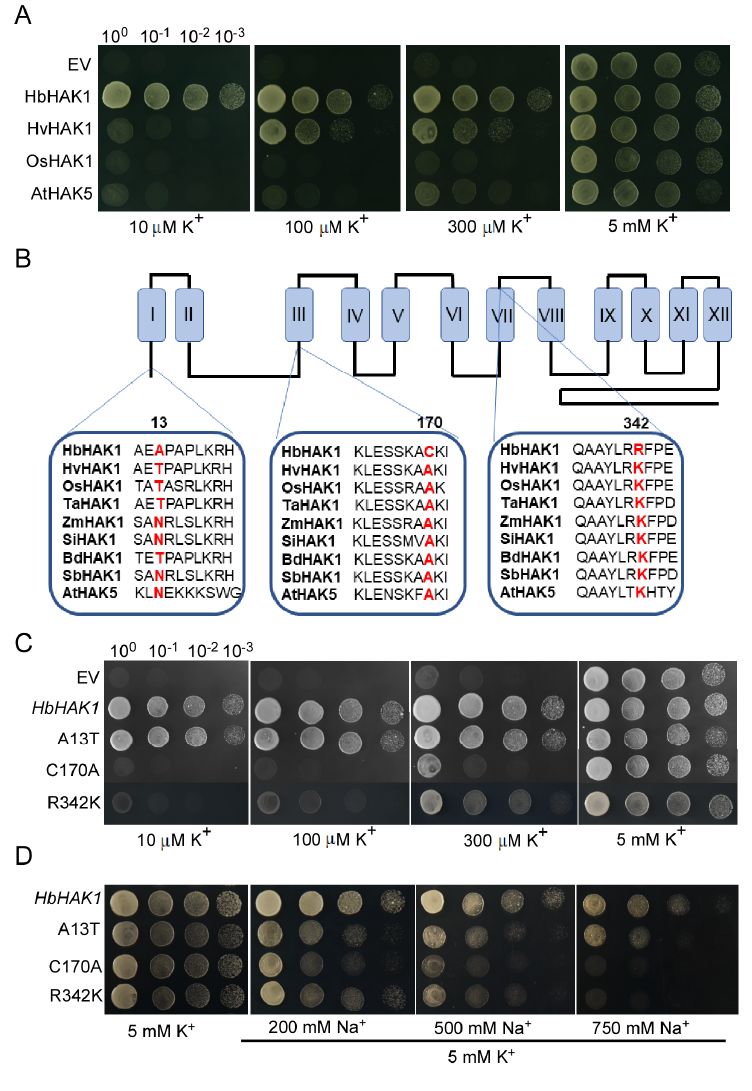
Figure 6. Main amino acids of HbHAK1 a ff ected the transport activity. ( A ) Growth of Cy162 strains transformed with p424, p424- HbHAK1 , p424- HvHAK1 , p424- OsHAK1 and p424- AtHAK5 in solid AP-T medium with various K + concentrations; ( B ) HbHAK1 topology and the location of three significant amino acid. The proposed model for HbHAK1 protein is shown with 12 transmembrane domains and a long tail in C-terminal. The A13 residue is located in N-terminal. The C170 is located between the second and the third transmembrane domain. The R342 is located in the seventh transmembrane domain; ( C ) growth of Cy162 strains transformed with WT HbHAK1 and the mutants A13T, C170A and R342K in solid AP-T medium with various K + concentrations; ( D ) growth of Cy162 strains transformed with WT HbHAK1 and the mutants A13T, C170A and R342K in solid AP-T medium with various Na + concentrations under 5 mM KCl.